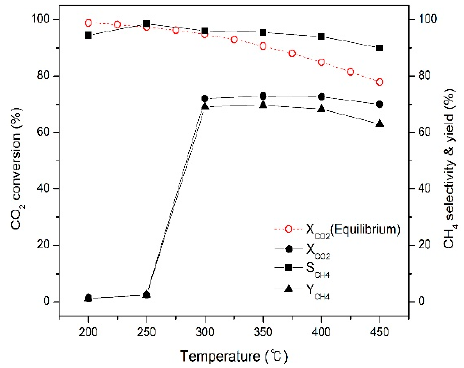
Figure 2. Effect of reaction temperature on CO 2 conversion and CH 4 selectivity.